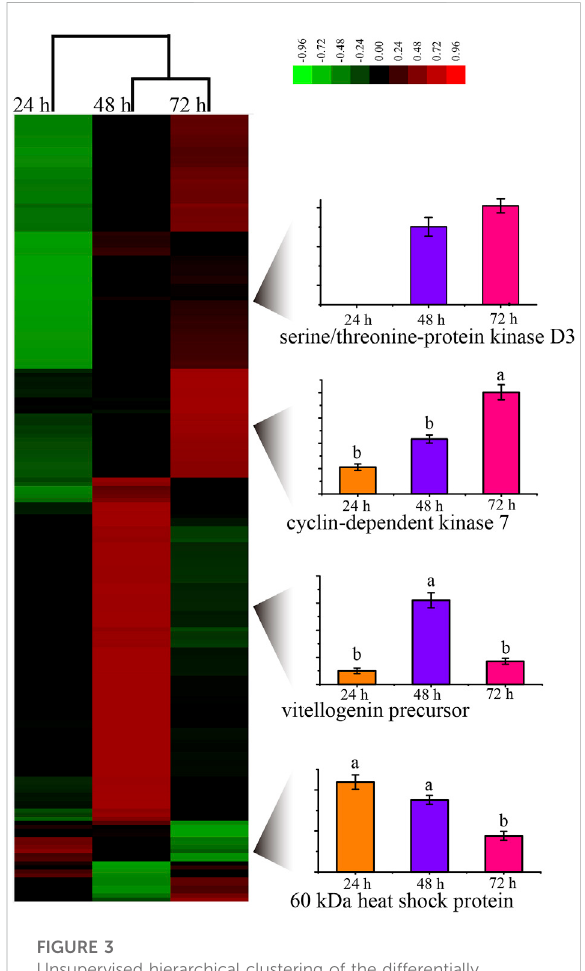
Unsupervised hierarchical clustering of the differentially expressed(foldchange ≥ 1.5and p < 0.05)proteinsintheembryoof honey bee workers. The columns represent the embryonic age (24, 48, and 72 h), and the rows represent the individual proteins. The up- or downregulated proteins are indicated by red and green color codes, respectively. The color intensity changes with the protein expression level, as noted on the key bar on the top right. The histograms denote the expression trend of the representative proteins during the embryogenesis of the honey bee workers aged 24, 48, and 72 h,